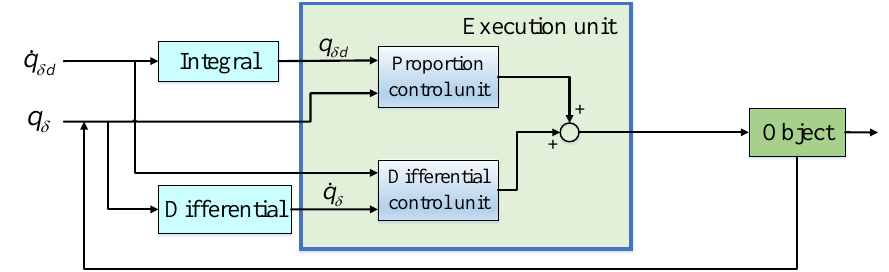
Figure 3. Control structure of the controller.